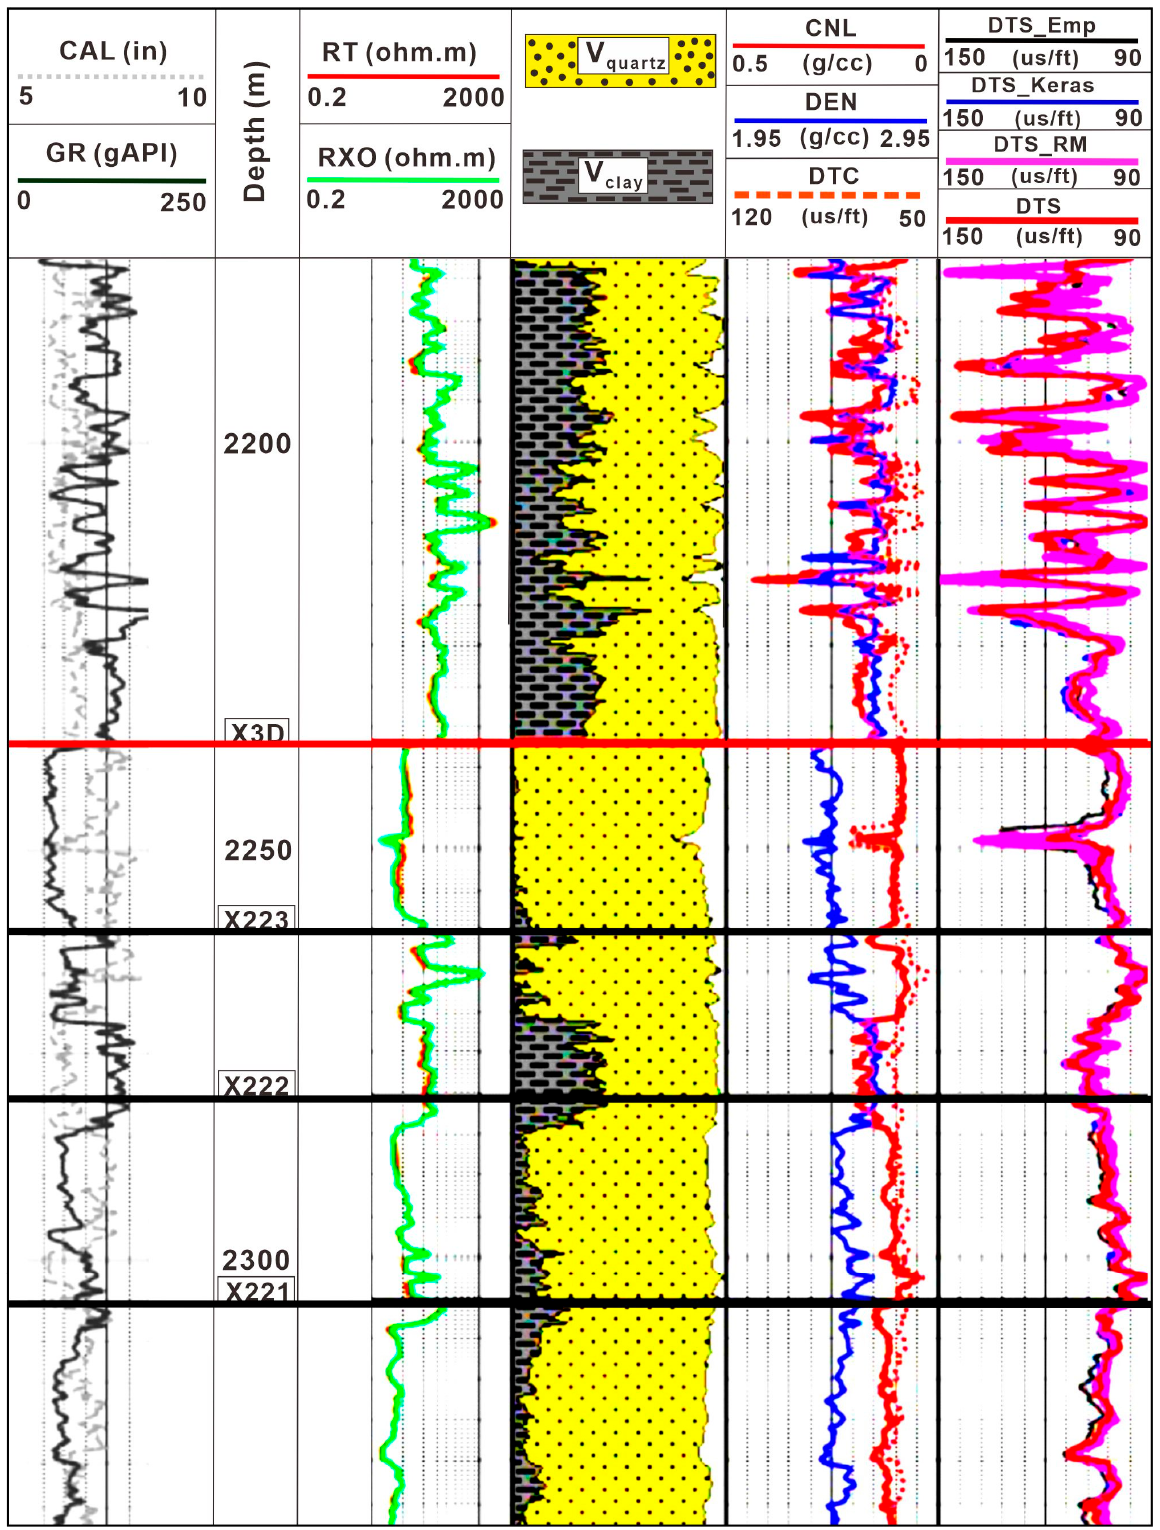
Figure 17. Comparison of S-sonic curves predicted by different methods (dts_emp, DTS_RM, KERAS_DTS were calculated, respectively, by the empirical formula, the rock physics modeling method, deep learning, and DTS is the measured S-sonic